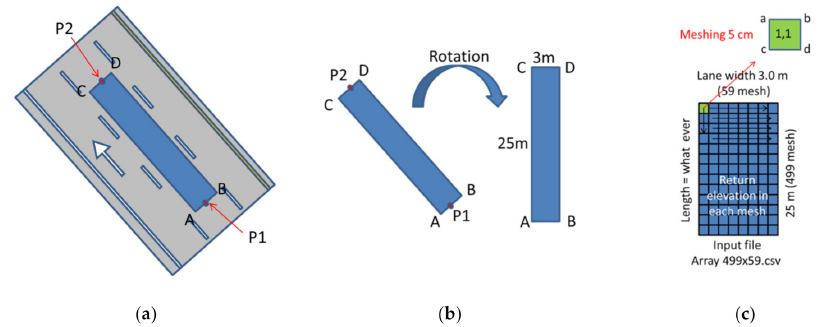
Figure 9. ( a ) Cropped area of the road segment, ( b ) rotation performed for the ease of meshing, and ( c ) cropped area